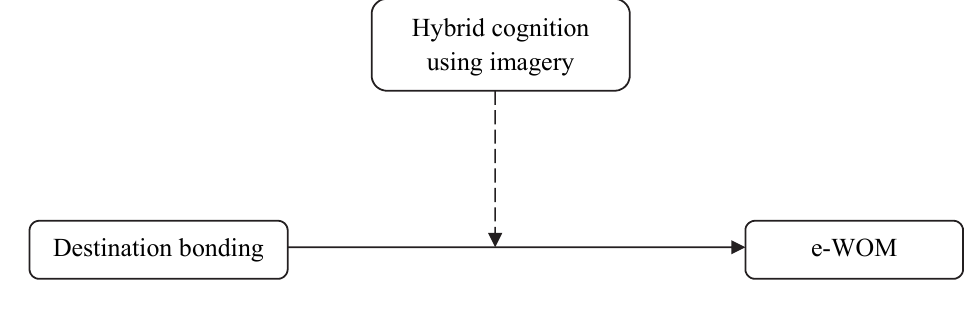
Fig.1. Conceptual/ default model for the